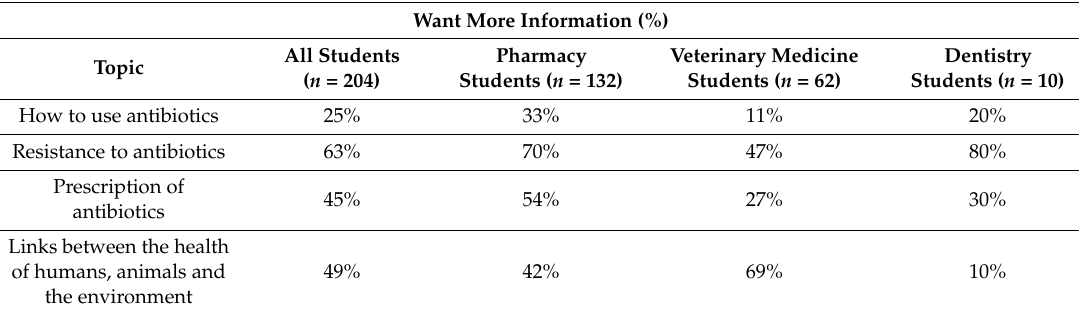
Table 2. Topics on which healthcare students want more